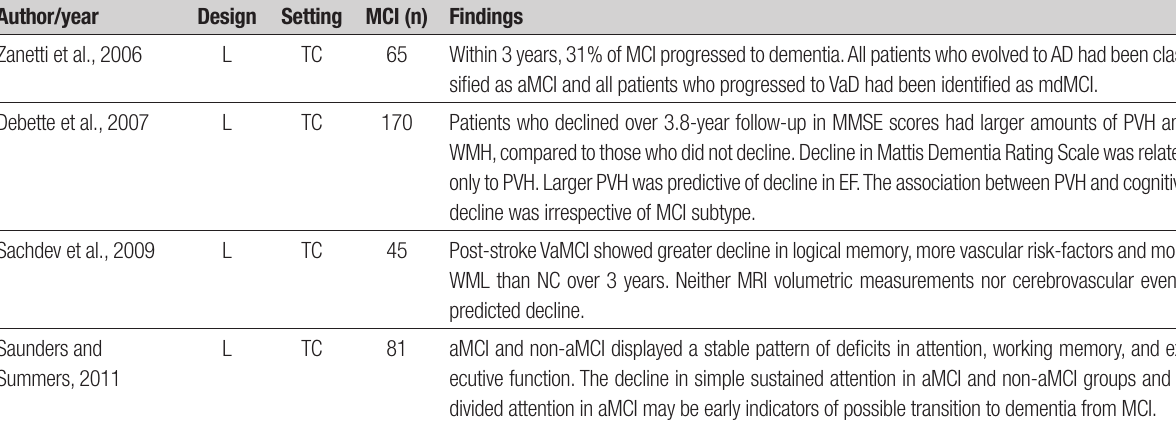
Table 3. Characteristics of studies on course of non-amnestic VaMCI included in this